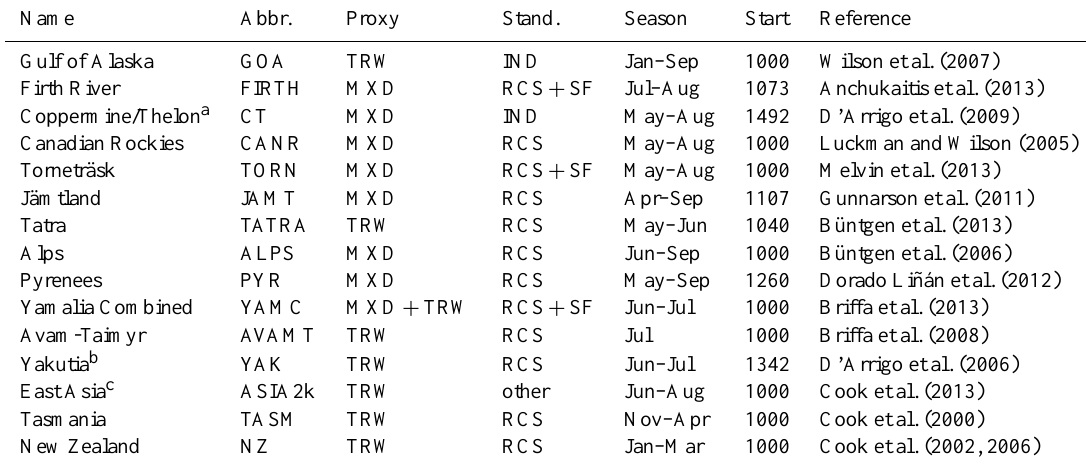
Table 1. Tree-ring temperature reconstructions used in this study, with seasonal representation as determined by the respective investigators. TRW – tree-ring width; MXD – maximum density; IND – individual standardization; RCS – regional curve standardization; SF – signal-free standardization. Short names and start year used in this study are also given.